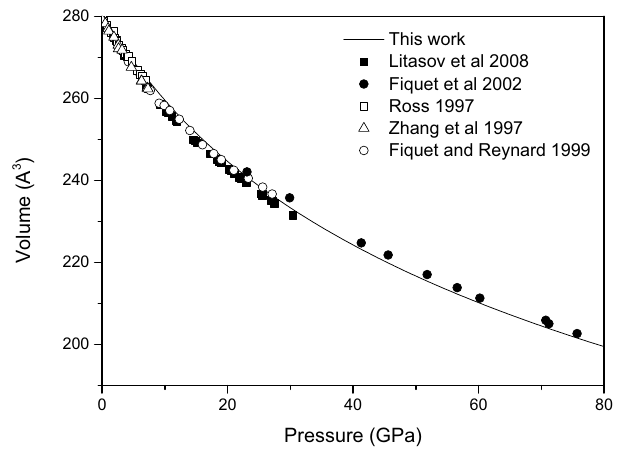
Figure 2. Equation of state for magnesite from 0 to 80 GPa.